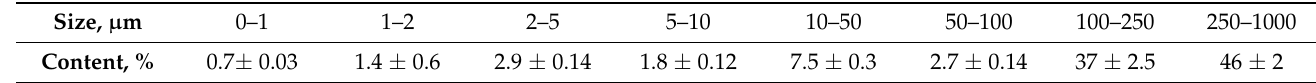
Table 1. Granulometric composition of the soil